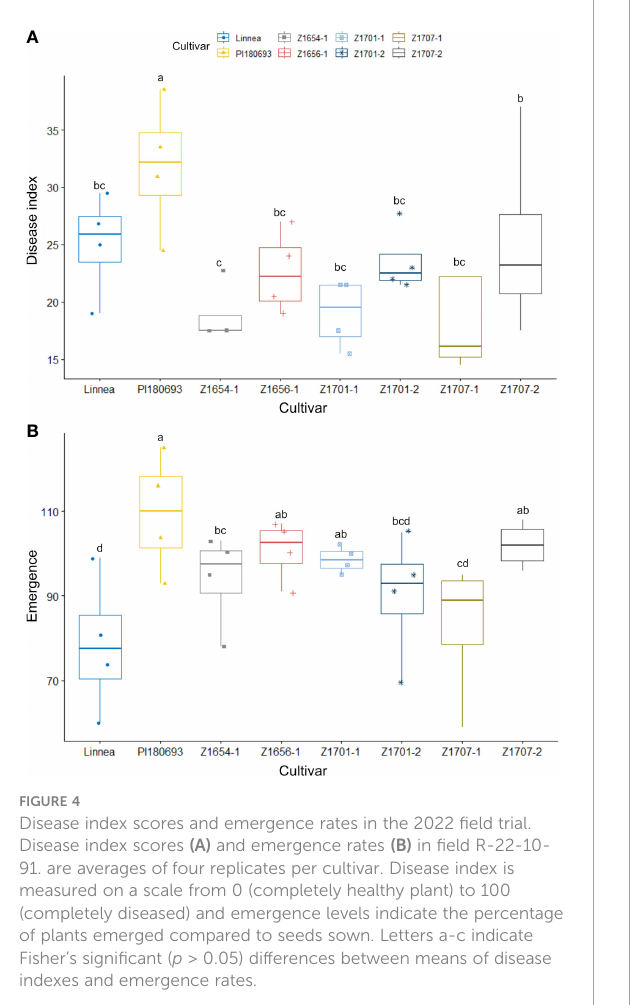
FIGURE 4 Disease index scores and emergence rates in the 2022 fi eld trial. Disease index scores (A) and emergence rates (B) in fi eld R-22-10- 91. are averages of four replicates per cultivar. Disease index is measured on a scale from 0 (completely healthy plant) to 100 (completely diseased) and emergence levels indicate the percentage of plants emerged compared to seeds sown. Letters a-c indicate Fisher ’ s signi fi cant ( p > 0.05) differences between means of disease indexes and emergence rates. Linnea phenotype. Breeding line Z1707-2 had signi fi cantly less ( p < 0.05, average 5.88) pods per plant than Linnea (average 7.5) while line Z1654-1 had more with an average of 9.12 (Supplementary Table 3).